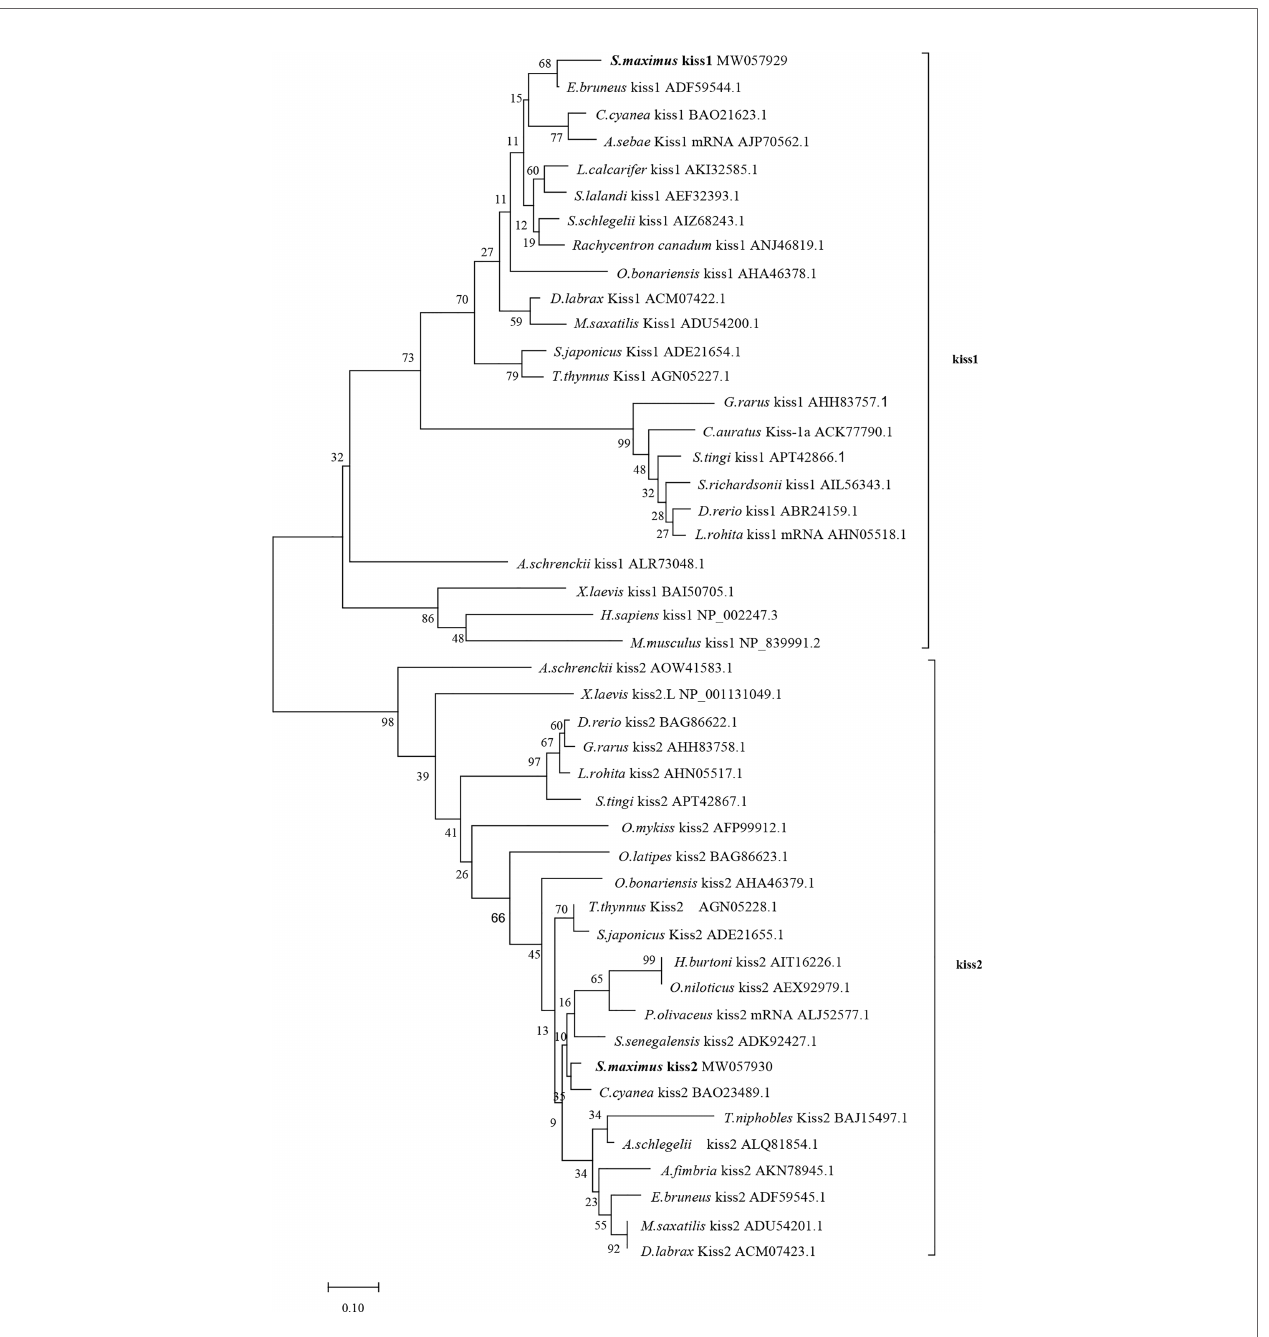
FIGURE 1 | Phylogenetic tree of deduced amino acid sequences of Kiss1 and Kiss2 from turbot and other vertebrates was constructed by Mega7 with neighbor- joining method. The bootstrap values at nodes indicate bootstrap percentage value for 1000 replicates (>80%). Relative branch lengths indicate the evolutionary rates of the lineages. The GenBank accession numbers of the sequences were presented after the species